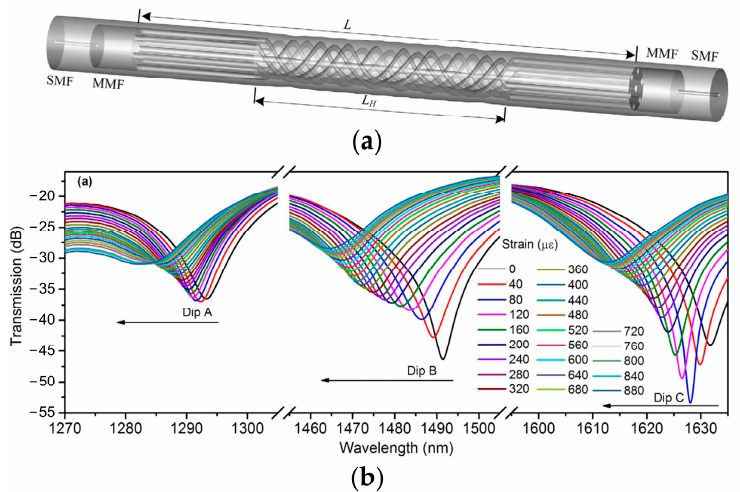
Figure 16. ( a ) The configuration of the proposed torsion sensor and axial strain sensor based on SCF with a helical structure [21,75]. ( b ) The axial-strain-induced wavelength shifts of dip A, dip B, and dip C with different sensitivities [75].